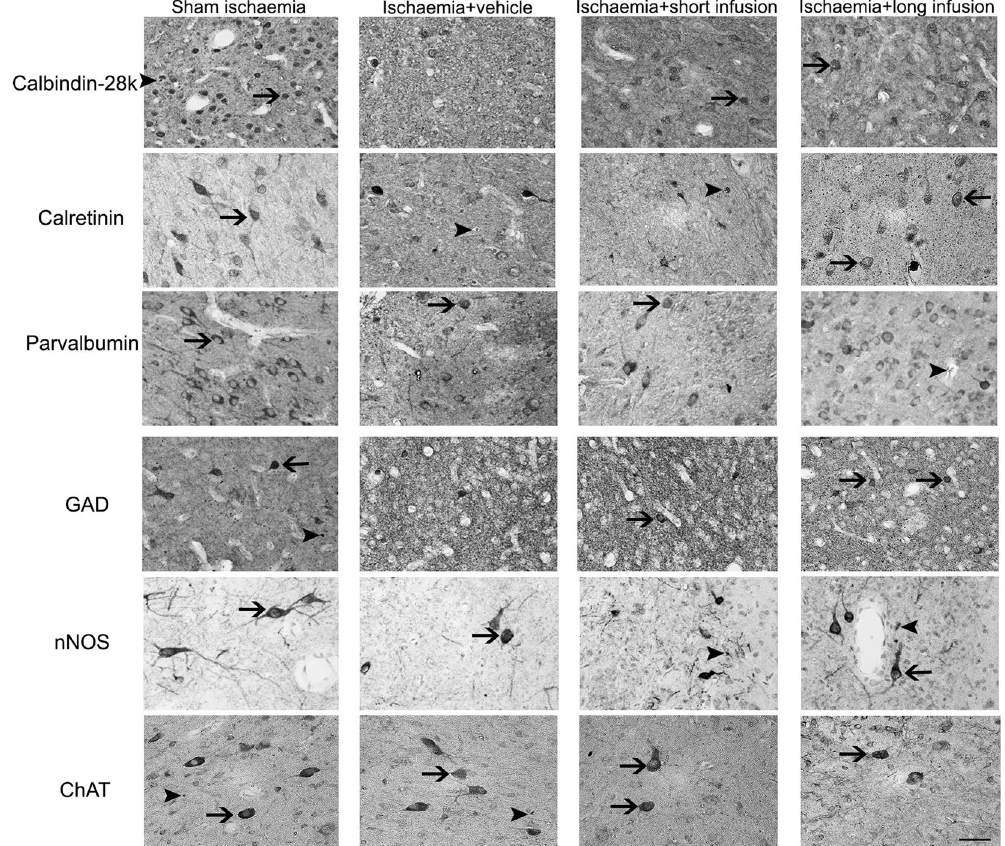
Figure 4. Representative photomicrographs of striatal phenotypic neurons in the putamen from sham ischaemia, ischaemia + vehicle, ischaemia + short infusion and ischaemia + long infusion groups at 40x magnification. Arrowheads with tail show examples of neurons that were counted, arrowheads show examples of neurons that were not counted. Scale bar is 200 µ